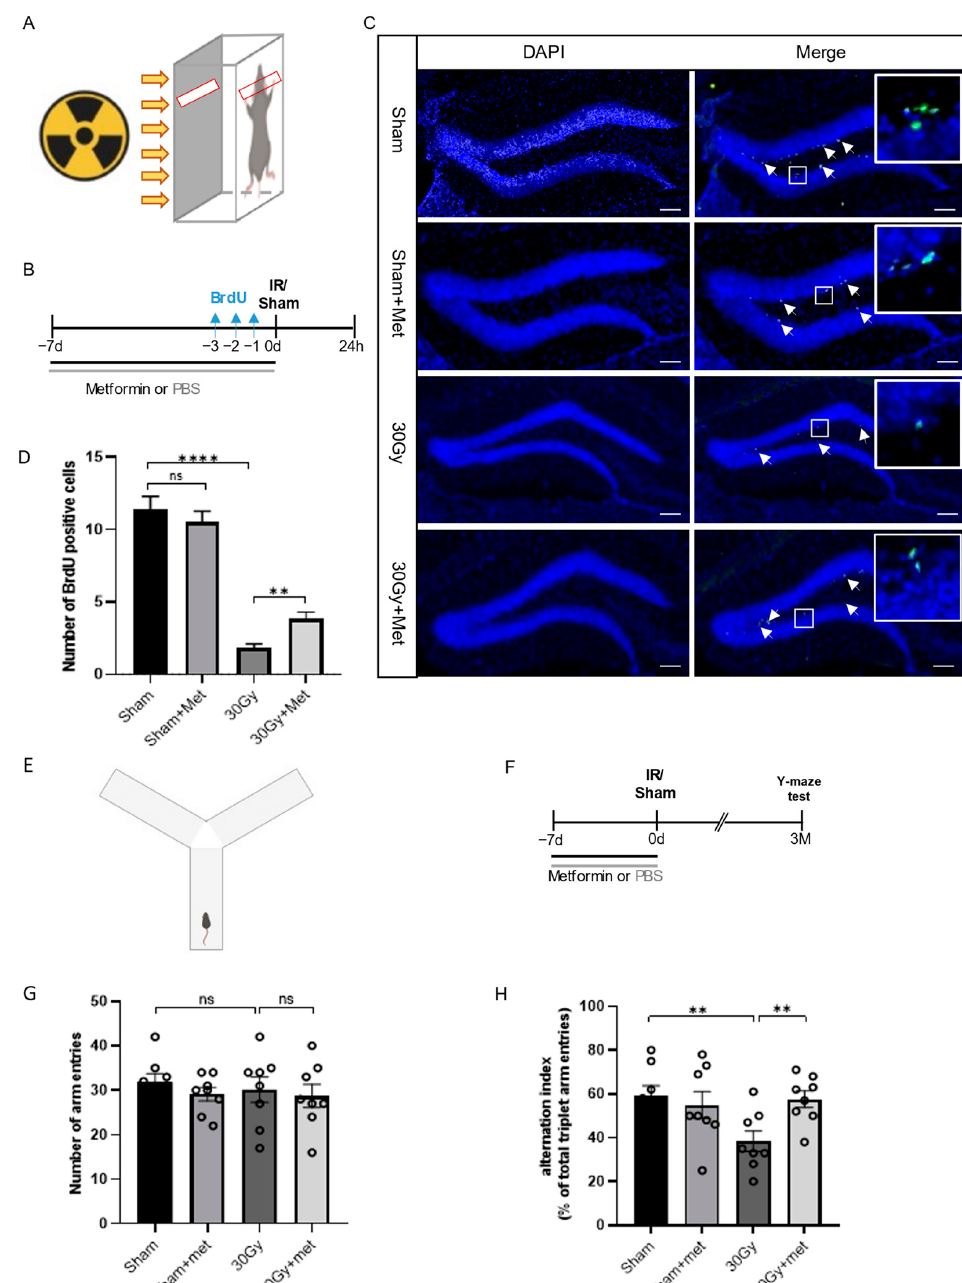
Figure 2. Metformin reduced the loss of neural stem cells and improved working memory scores and behavior in the acute phase of the whole-brain irradiation (WBI) mice model. ( A ) Schematic illustration of the irradiation exposure setup of mice. ( B ) Overview of the experimental timeline. IR, irradiation; PBS, phosphate buffer solution; d, day; h, hour. ( C ) Representative immunofluorescence visual field map. Met, metformin. ( D ) The number of BrdU-positive cells in the hippocampus of mice (30 Gy, n = 12). ( E ) Schematic of the Y maze test. ( F ) Overview of the experimental timeline. m, month. ( G ) The number of total arm entries in four different groups (30 Gy, n = 8/group). ( H ) The effects of metformin on the alternation index (% of total triplet arm entries) (30 Gy, n = 8/group). ** p < 0.01, **** p < 0.0001, n.s., not